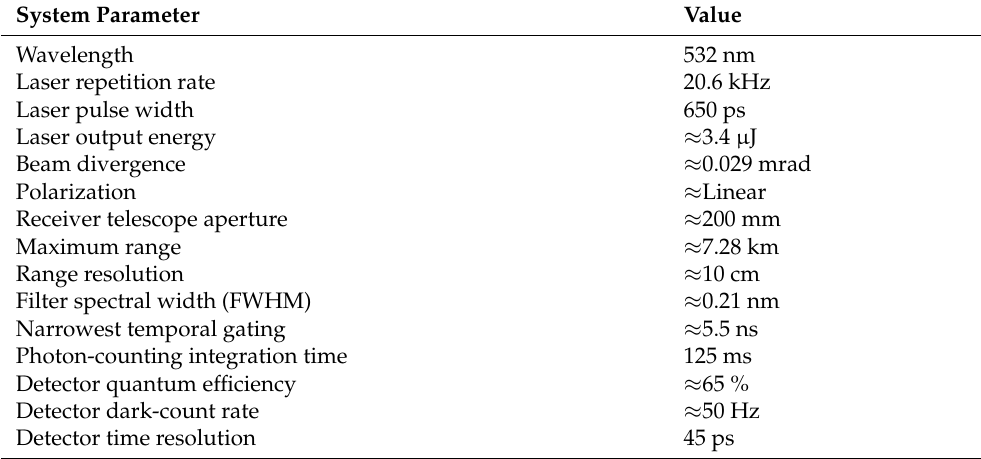
Table 2. Summary of the T2 lidar